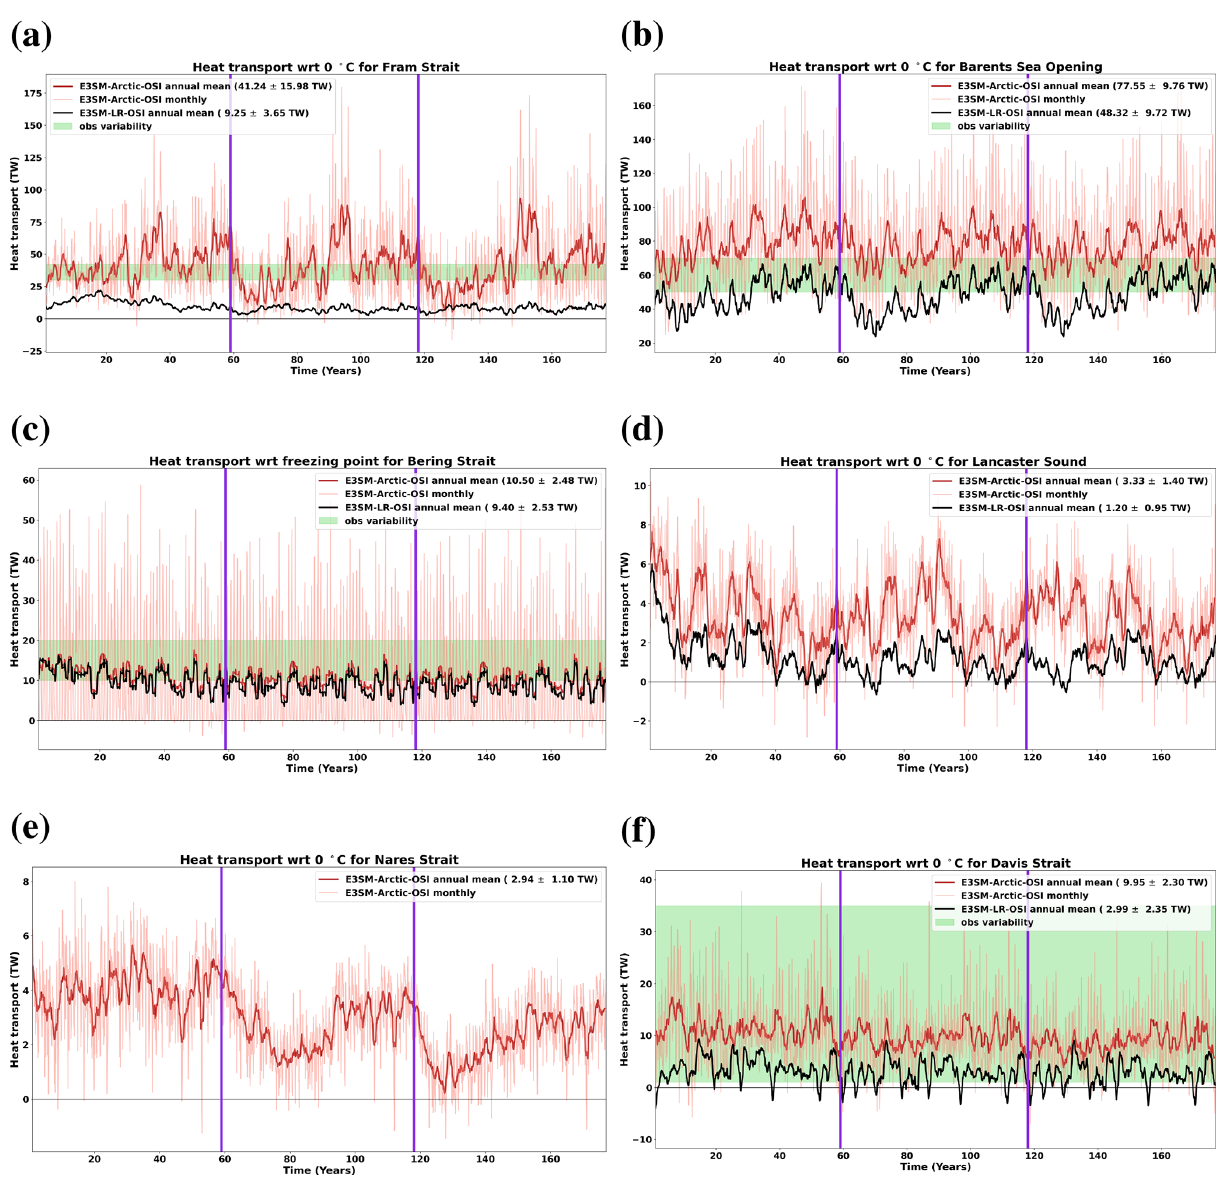
Figure 8. Similar to Fig. 7 but for net heat transport, which is computed with respect to the 0 ◦ C reference temperature in panels (a) , (b) , (d) – (f) , and with respect to the freezing point in panel (c) . Observational ranges, where available, are shaded in green; their values are 36 ± 6TW for the Fram Strait (Schauer and Beszczynska-Möller, 2009), between 50 and 70TW for the BSO (Smedsrud et al., 2010), between 10 and 20TW for the Bering Strait (Woodgate et al., 2010, these authors use the freezing point as reference temperature, as done for the model estimates), and 18 ± 17TW for the Davis Strait (Cuny et al.,